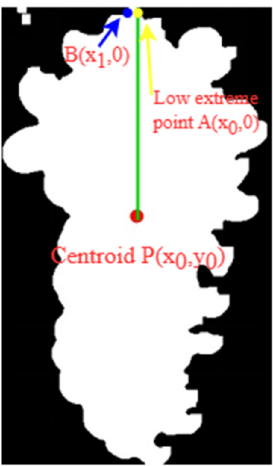
Figure 11. Center of mass locations.